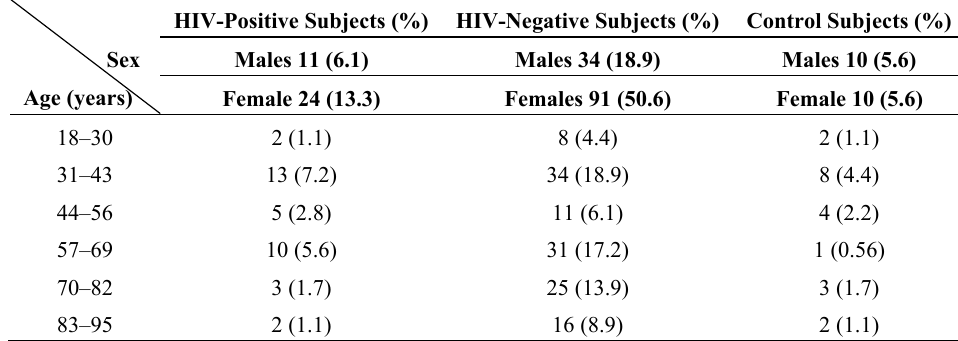
Table 1. Demographic characteristics of study subjects with respect to sex and age